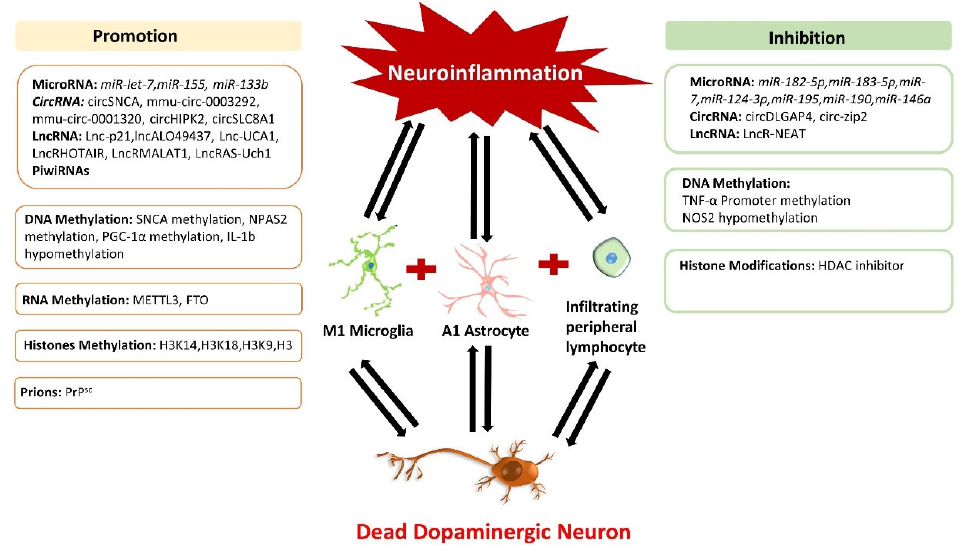
Figure 1. Impact of epigenetic mechanisms regulating neuroinflammation in Parkinson’s disease. The neuroinflammation cycle is activated on DA neuron damage, which triggers epigenetic modifications and disturbs the normal function of inflammatory responses. Epigenetic regulators are divided into two categories: neurotoxic and neuroprotective. Neurotoxic epigenetic regulators enhance inflammatory factors and ROS production, transform glial cells to an inflammatory phenotype, and promote dopaminergic neuron death. In contrast, neuroprotective epigenetic regulators display therapeutic characteristics and inhibit neuroinflammation by alleviating DA neuronal damage in Parkinson’s disease.